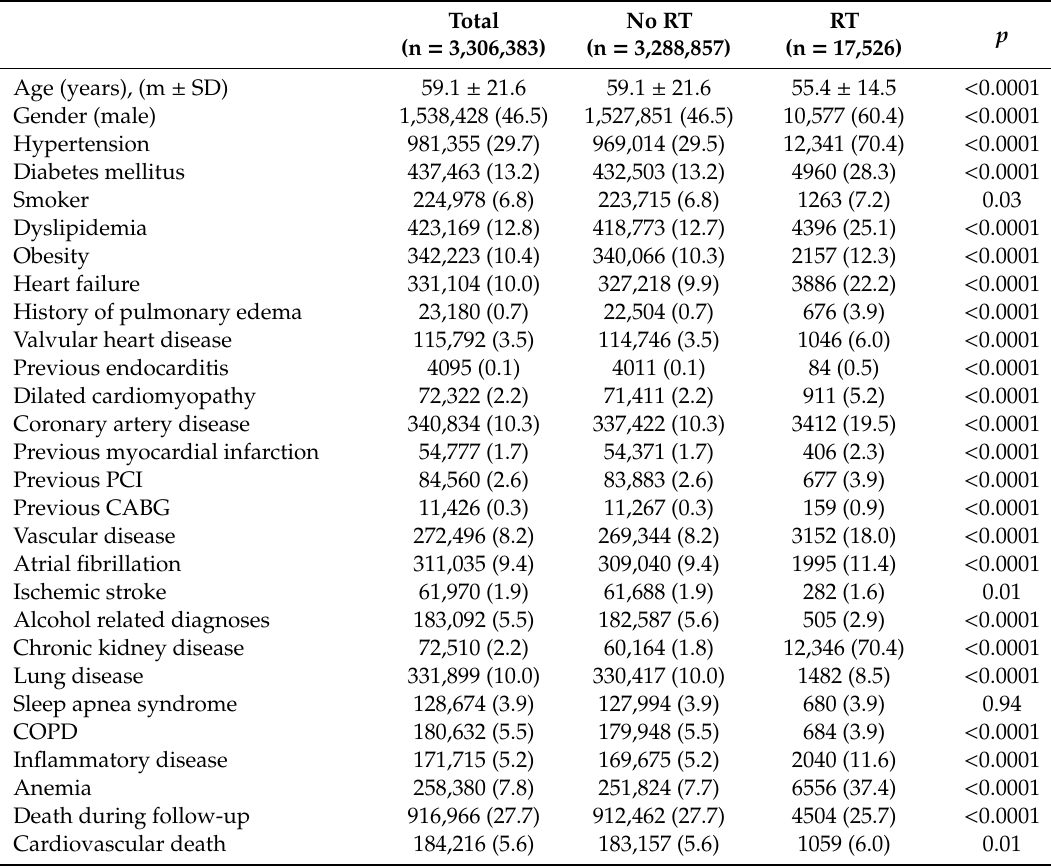
Table 1. Baseline characteristics of patients admitted in French hospitals in 2013 with at least a 5-year